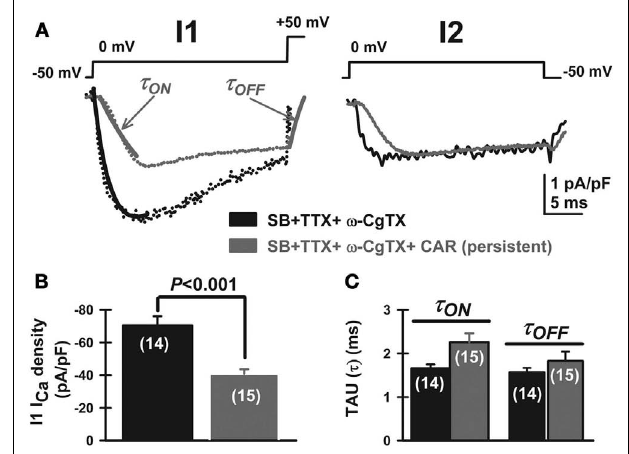
FIGURE 5 | Carbachol-mediated voltage-dependent G-protein modulation of P/Q-type voltage-gated calcium currents in PPN . (A) Three-pulse protocol used to study the voltage dependence of G-protein modulation of calcium currents (I Ca ) in PPN neurons after blocking N-type channels with ω -conotoxin-GVIA 2.5 µ M. In the presence of synaptic receptor blockers (SB: GBZ + STR + AP5 + CNQX),TTX, MEC, and ω -CgTX-GVIA, calcium current density (I Ca ; pA/pF, black record) was reduced in amplitude by CAR (gray record) when the three-pulse protocol was applied as described in Figure 4 . (B) CAR (30 µ M) reduced the total amount of current density after the first pulse (before CAR black column, after CAR gray column; Mann–Whitney Rank SumTest, p < 0.001). (C) Time course of activation ( τ ON ) and deactivation ( τ OFF ) of calcium currents, obtained after fitting individual currents to the function y = y 0 + a × exp ( − [ − Time (ms)/ τ (ONorOFF) ).The effects of CAR on time course were not significantly different (Kruskal–Wallis ANOVA, H = 4.33, p = 0.23). (Abbreviations: